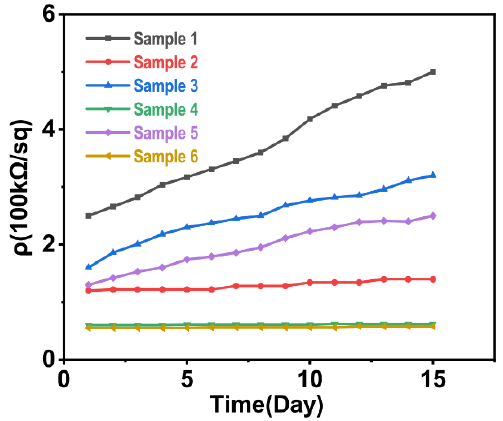
Figure 7. Changes in the surface resistivities of samples 1–6 with time.